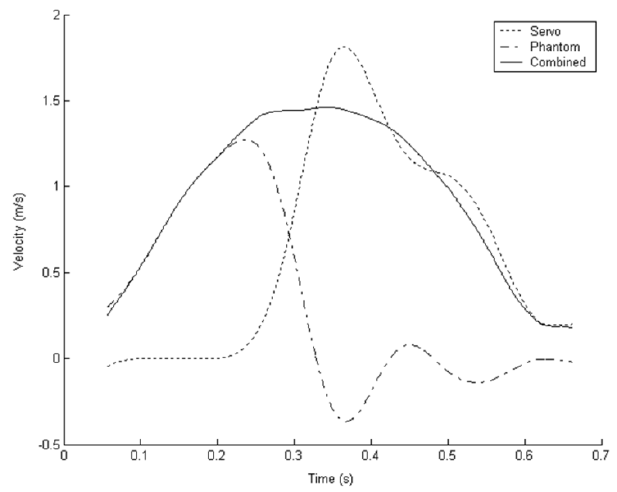
Figure 11. Averaged velocity profile for the reciprocal tapping task. The controller includes dead-band and acceleration compensation components.